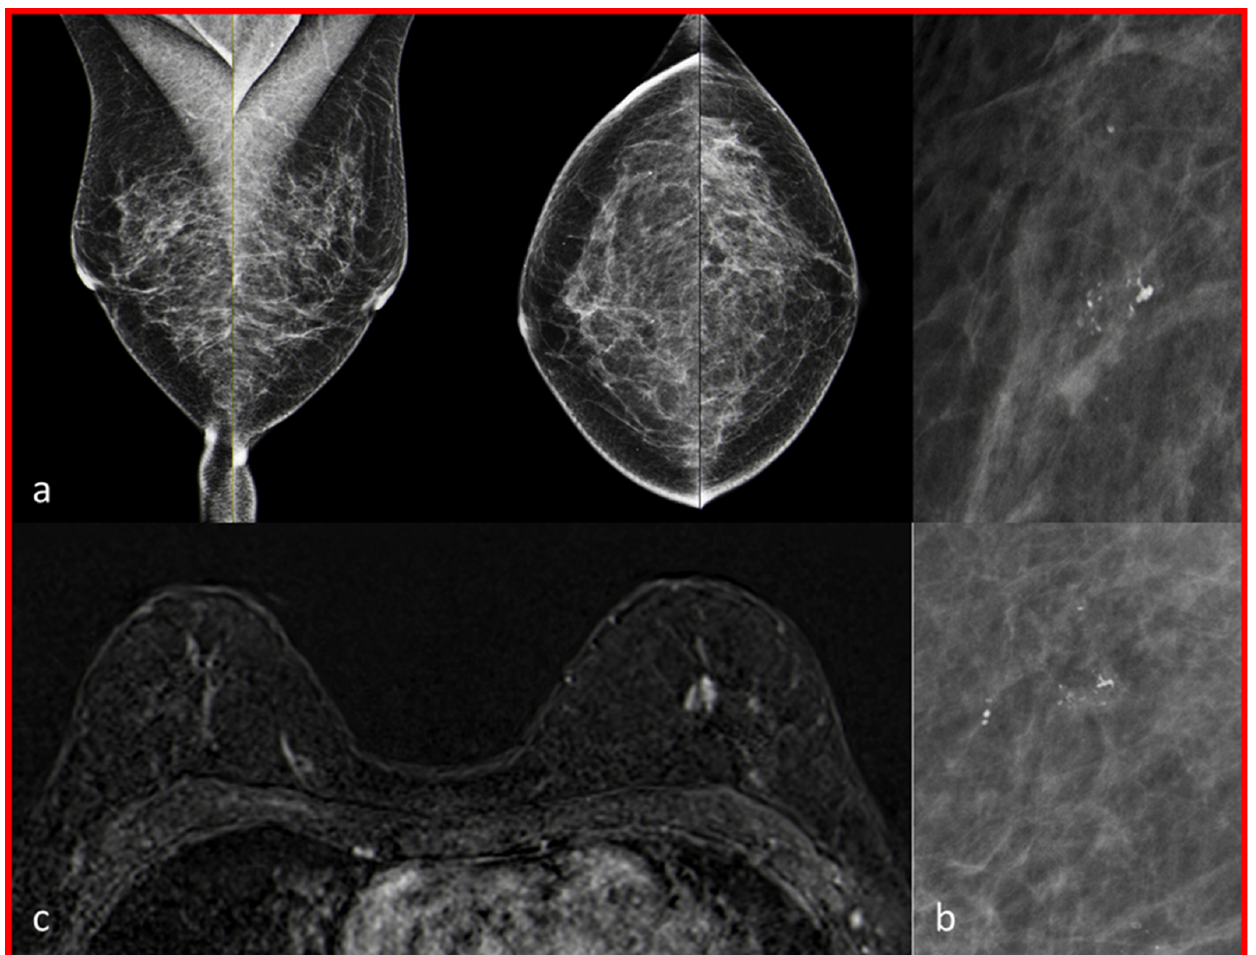
Figure 3. The mammography and breast magnetic resonance images (MRI) of patient number five of Table 2 are shown. Grouped, coarse, heterogeneous microcalcifications (MCs) in the mammography (MG) of the right breast (subfigure ( b ), enlargement of the microcalcifications of subfigure ( a ), histology: low-grade DCIS). Inconspicuous MG of the left breast. In breast magnetic resonance imaging, no suspicious lesion was detected in the right breast. A non-mass enhancement was found in the left breast (image ( c ), histology: breast cancer, NST G2).